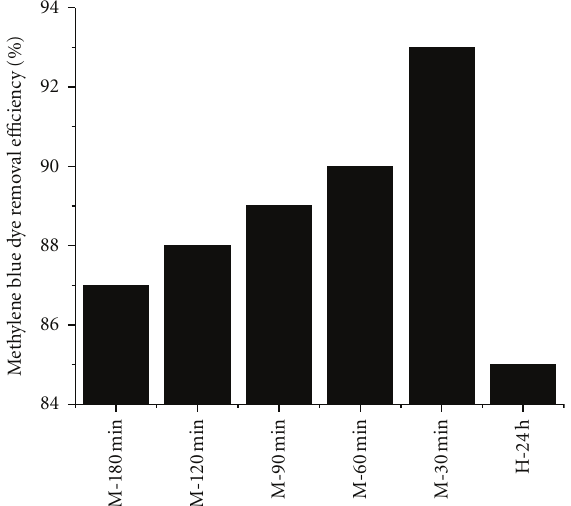
Figure 5: E ff ect of irradiation time and preparation method on photocalytic e ffi ciency percentage of methylene blue